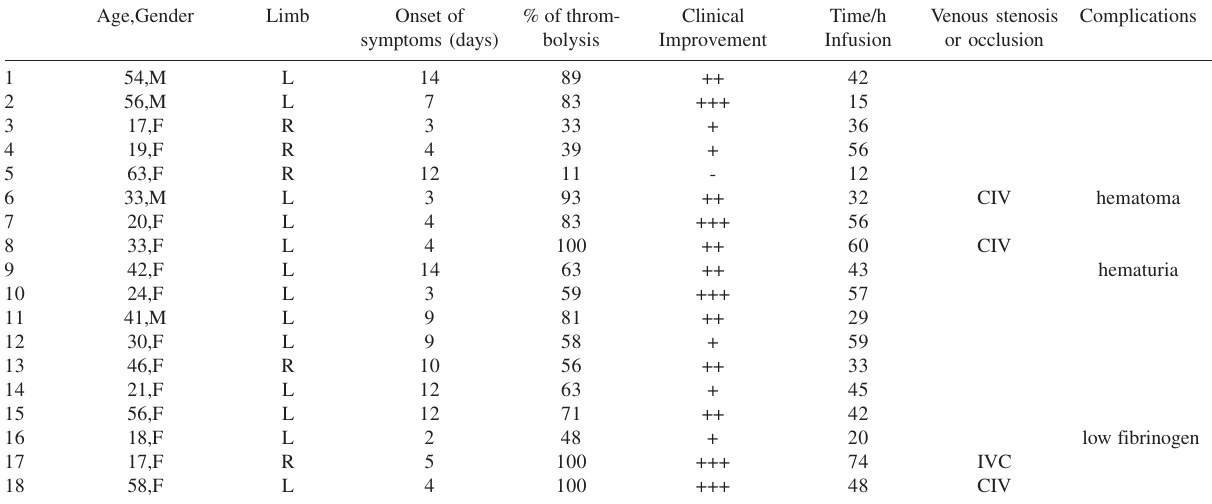
Table 1 - Clinical characteristics and initial results of thrombolysis